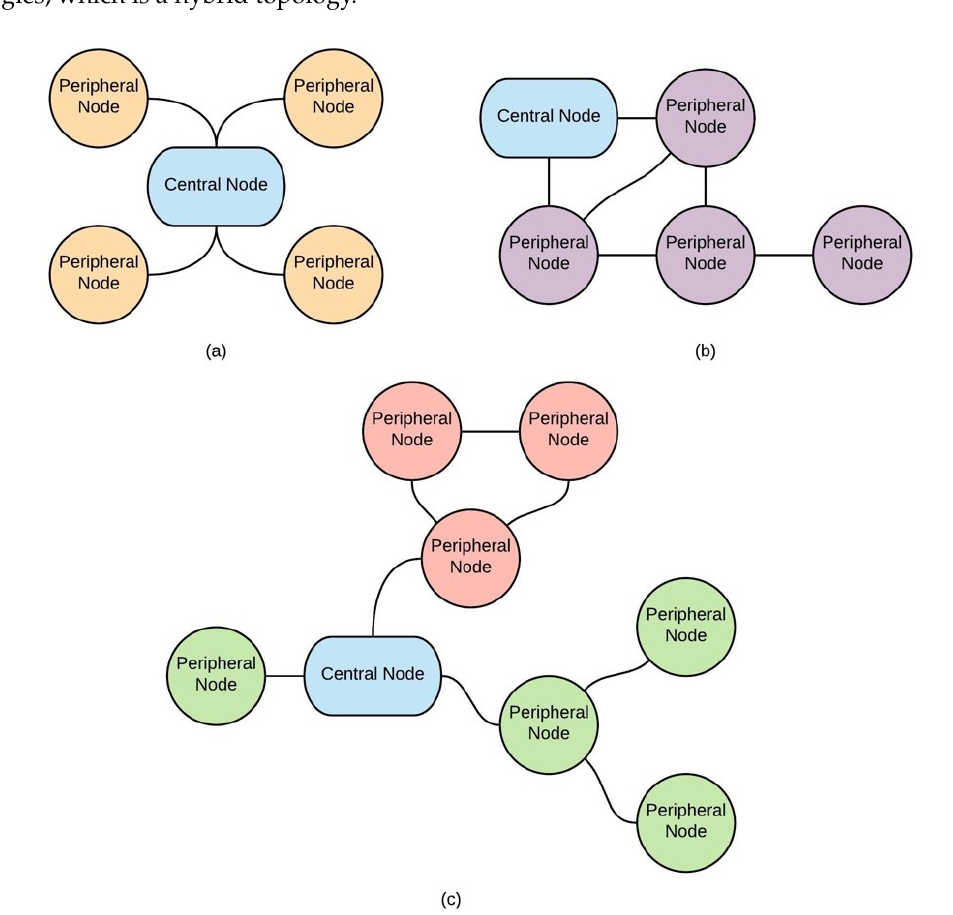
Figure 2. Body area network topologies: ( a ) star topology; ( b ) mesh topology; and ( c ) hybrid